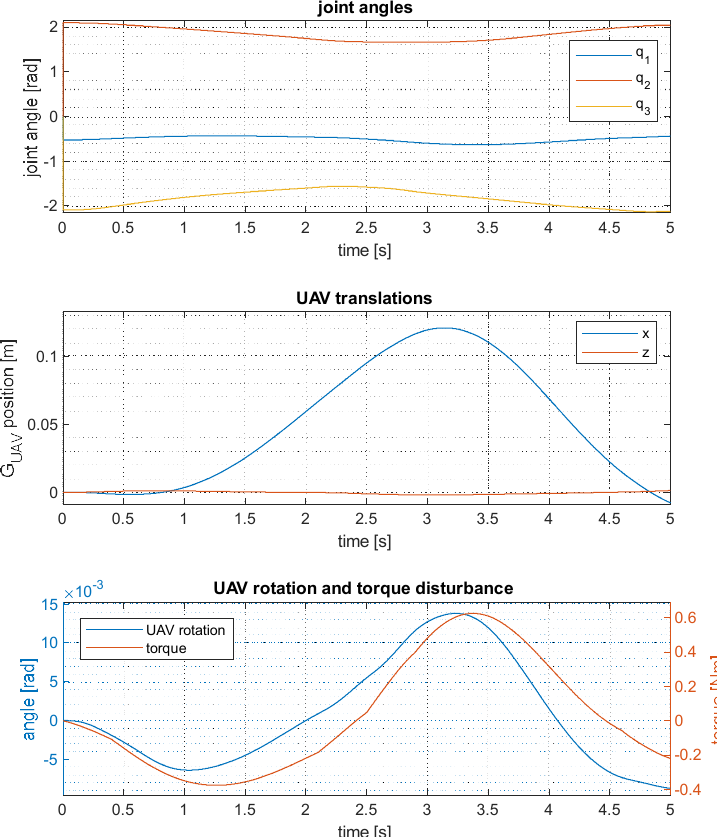
Figure 13. Manipulator ( top ) and UAV motions and torque disturbance ( middle and bottom ) for the 3-DOF UAM using the generalized Jacobian with external forces performing a linear trajectory task.